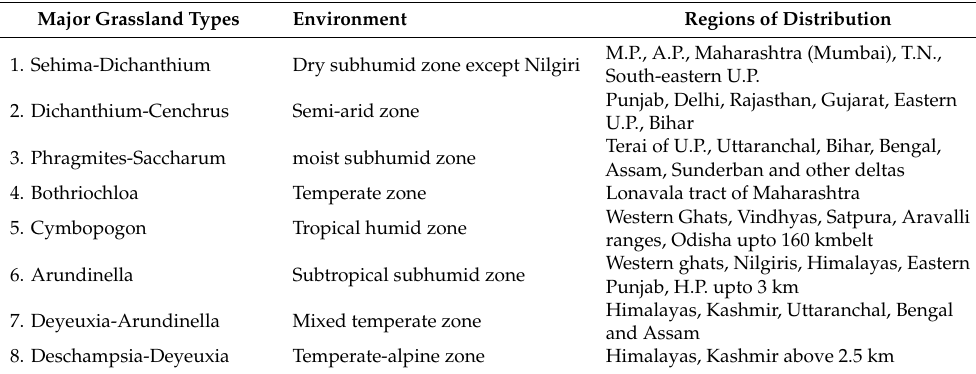
Table 1. Major grassland types of India alongwith environment and regions of distribution [16]. Major Grassland Types